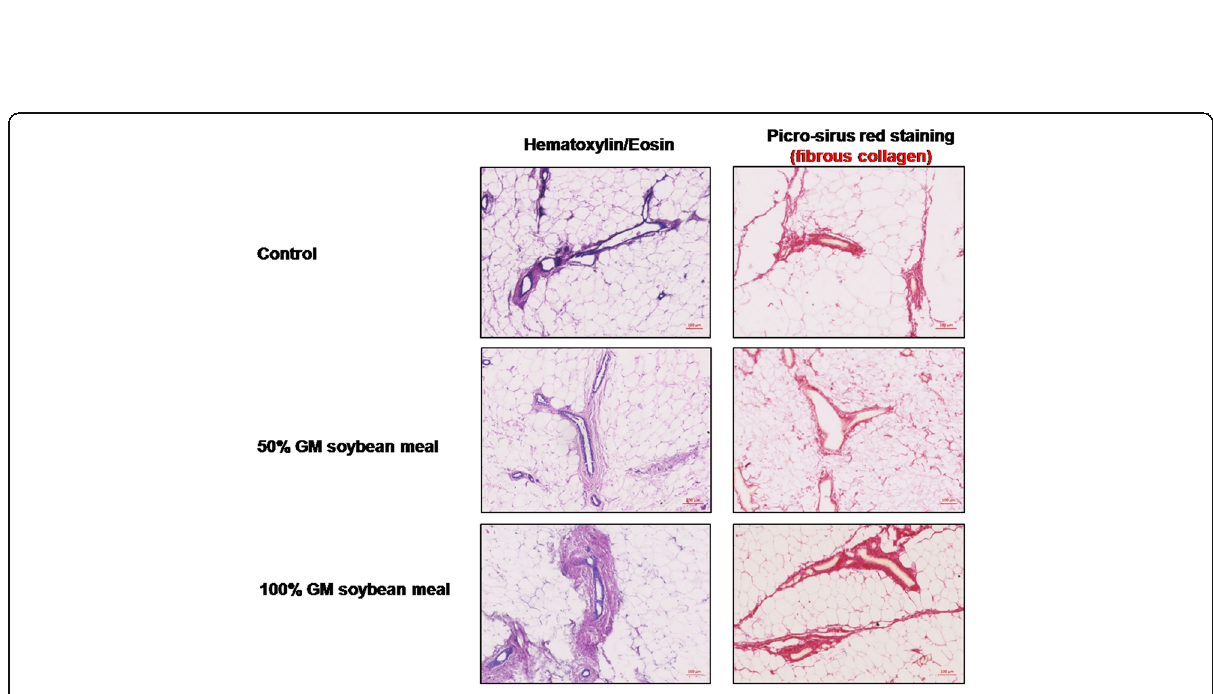
Fig. 6 Histological examination of mammary gland tissue in female Wistar rats, stained with hematoxylin/eosin and picrosirus red showing thickened, more prominent fibrous layer around mammary ducts distant from lymph node region in the 100% GM soybean group (lower panel). The signs of acini formation are present, although the animals were not pregnant and had passed puberty phase. Scale bar is 100 μ